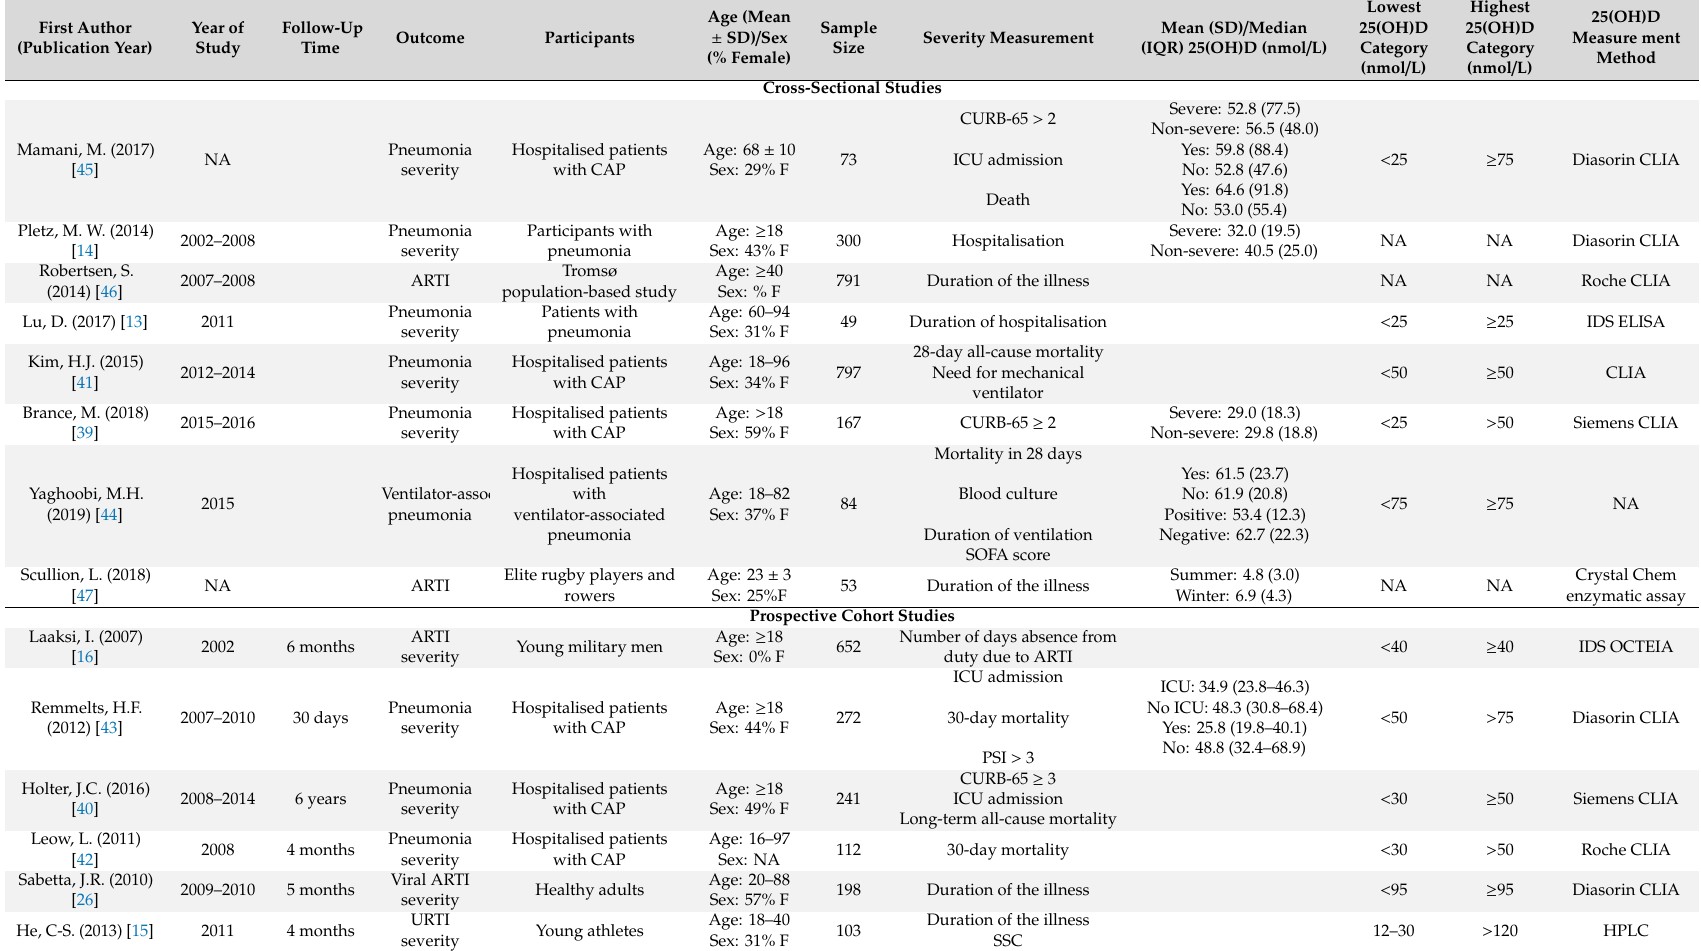
Table 2. Characteristics of studies reporting the association between severity of ARTI and